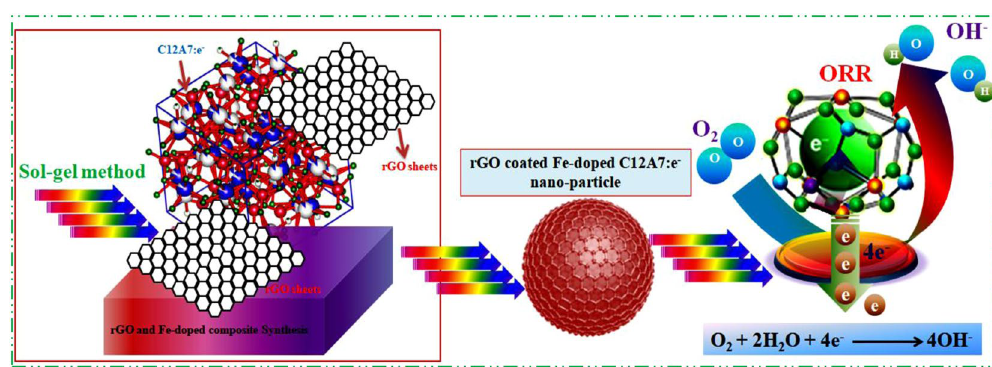
Scheme 1. Schematic presentation of ORR on the envisage microstructure of rGO coated Fe-doped C12A7:e −